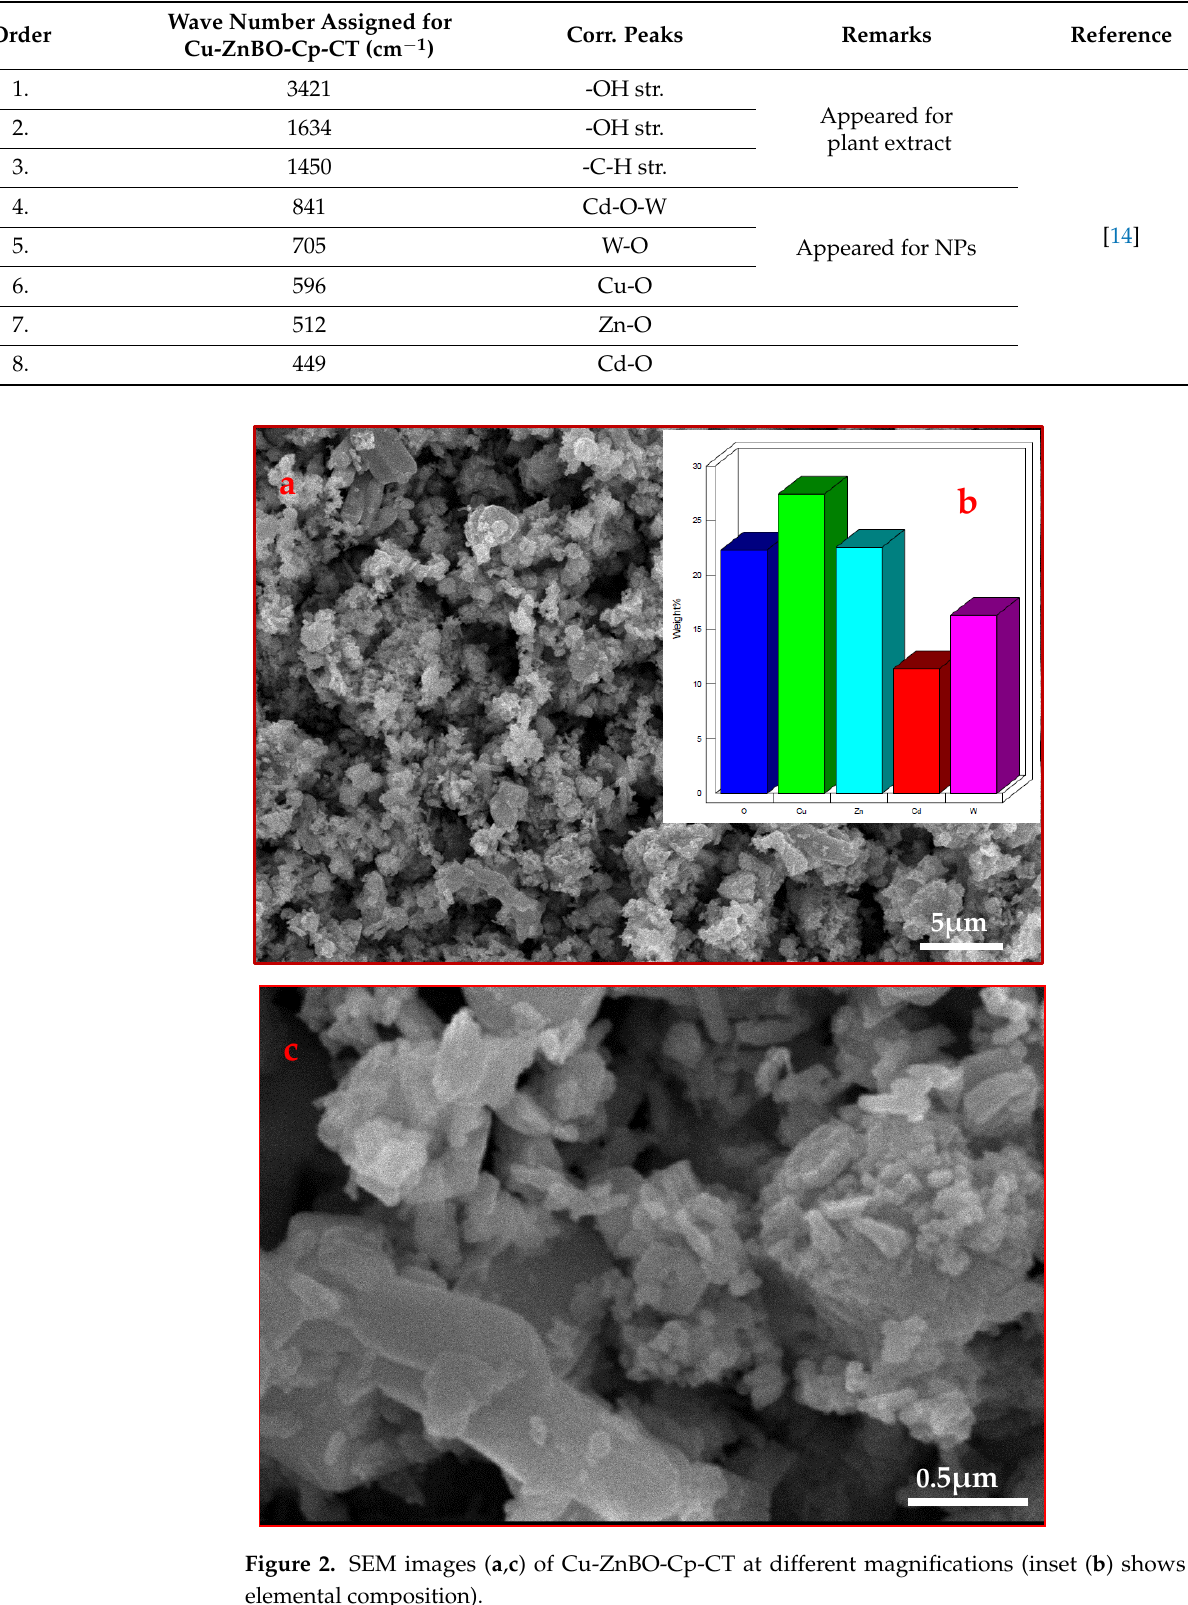
Figure 3. TEM images of Cu-ZnBO-Cp-CT.